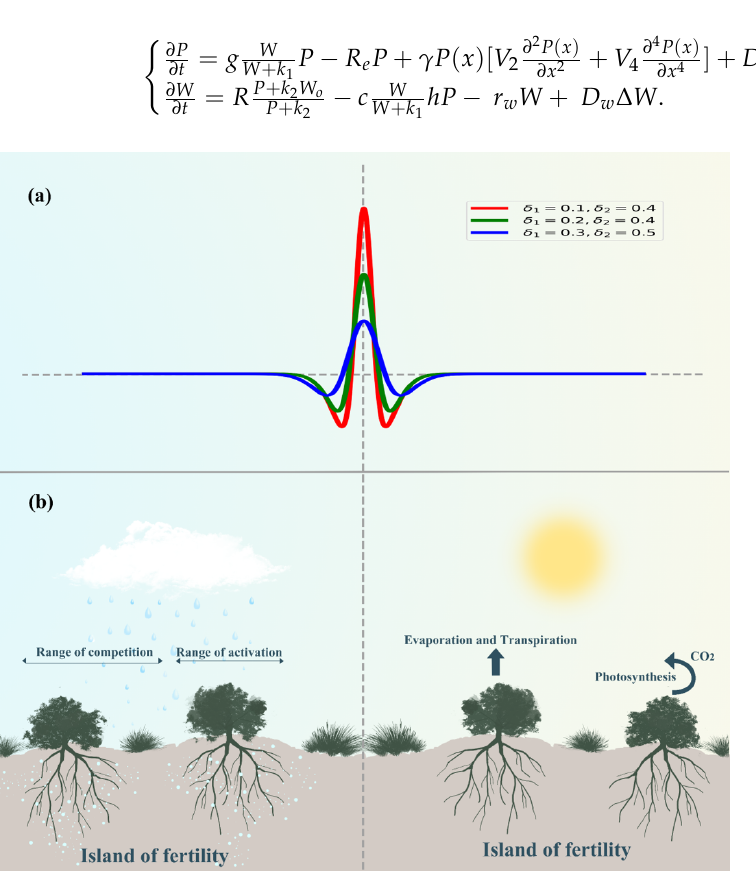
Figure 3. ( a ) Illustration of the kernel function V ( x ) with different δ 1 and δ 2 . ( b ) Sketch of the model with the effects of photosynthesis and respiration. Description of the island of fertility and non-local competition interaction: short-range activation and long-range